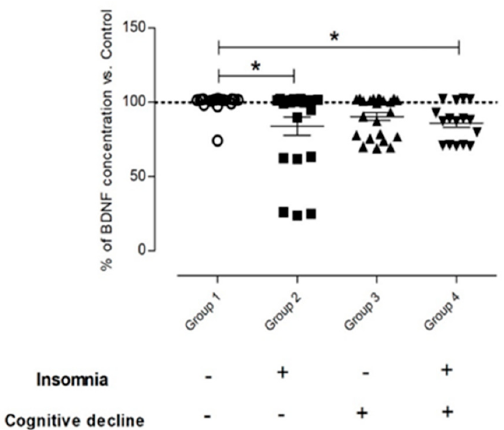
Figure 2. The BDNF concentration in individuals with insomnia is like those individuals with cogni- tive decline. This plot depicts the concentration of BDNF in serum samples of older individuals according to their group. Group 1 (n = 22) 9614.7 ± 571.5 pg/mL; Group 2 (n = 21) 8034.2 ± 2634.8 pg/mL; Group 3 (n = 23) 8691.3 ± 1257.9 pg/mL; Group 4 (n = 14) 8157.4 ± 1160.3 pg/mL. Group 1 vs. Group 2 * p = 0.0029; Group 1 vs. Group 4 * p = 0.0051. One-way ANOVA; post hoc test: Dunns’ test. Circles correspond to Group 1 (Non-insomnia and non-cognitive decline, Control), squares corre- spond to Group 2 (Only insomnia), upward-pointing triangles correspond to Group 3 (Only cogni- tive decline), and downward-pointing triangles correspond to Group 4 (both insomnia and cogni- tive decline).